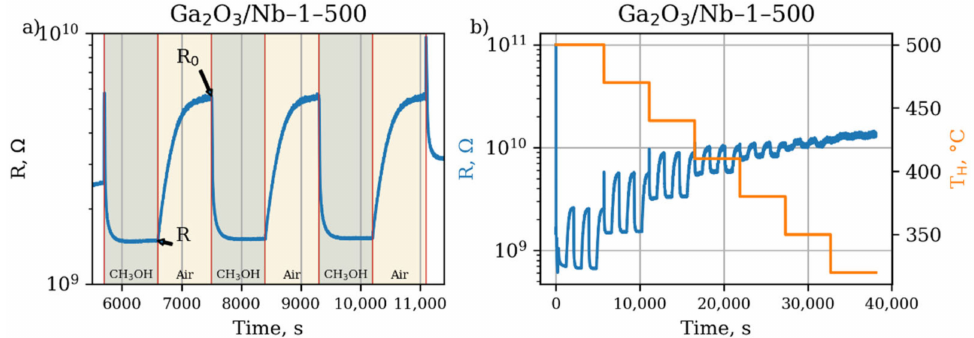
Figure 7. Dependence of Ga 2 O 3 /Nb-1-500 sensor material resistance on experiment time during the process of response measurement towards 20 ppm of methanol in dry air at ( a ) fixed working temperature 470 ◦ C ( b ) different sensor working temperatures. Designations “R” and “R 0 ” on the Figure 7a indicate the resistance of sensitive layer in the presence of methanol 20 ppm and in the flow of clean air, respectively, which are used to calculate sensor response according to Equation